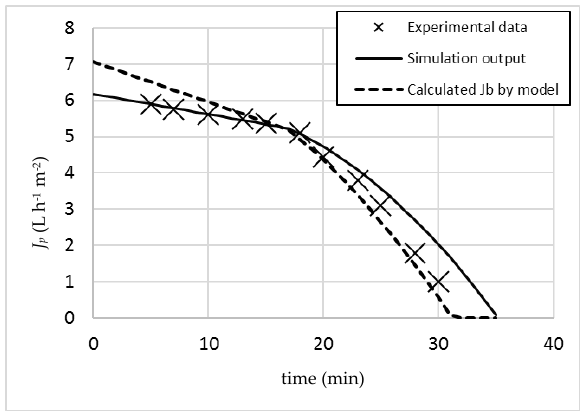
Figure 3. Comparison of the simulation with the obtained experimental data.